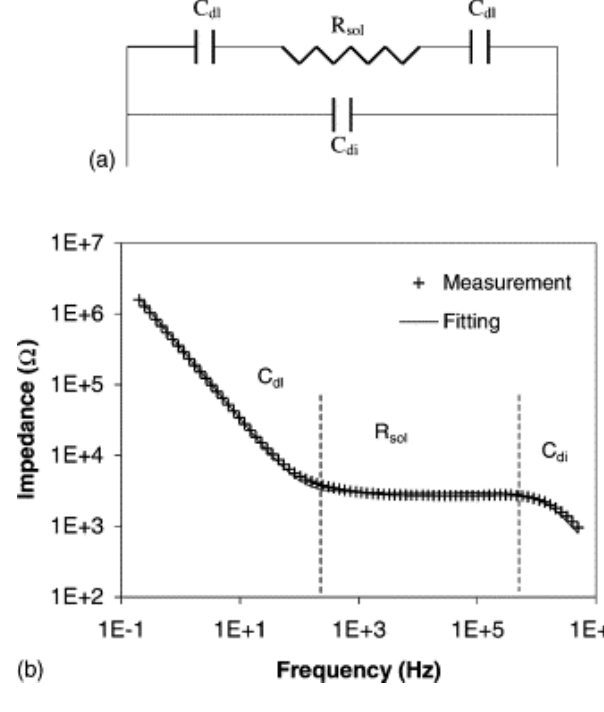
Figure 1. ( a ) Electrical equivalent circuit of impedance measurement system with interdigitated electrode. ( b ) Typical impedance spectrum. C is the double layer capacitance at dl each electrode. R is the resistance of the medium. C is the dielectric capacitance of the sol di medium. (Copyright 2004. Reprinted from [22] with permission from